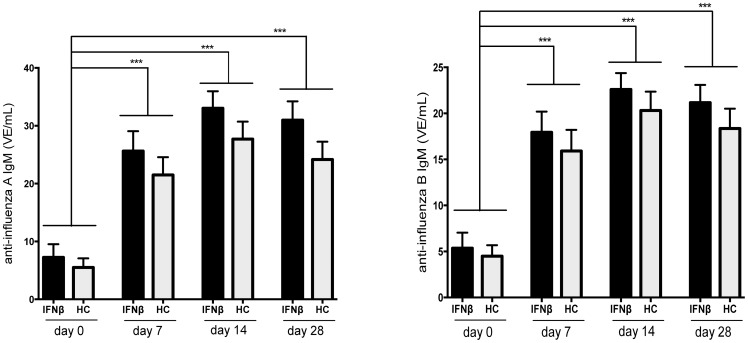
Anti-influena IgM-response after influenza-vaccination in IFNβ-treated patients and in healthy controls.The concentration of anti-influenza A (panel A) and anti-influenza B (panel B) IgM is shown as detected before (day 0) and at day 7, 14 and 28 after influenza vaccination in IFNβ-treated patients with MS (IFNβ) and healthy controls (HC) (mean + SEM). *** indicates p< 0.0001